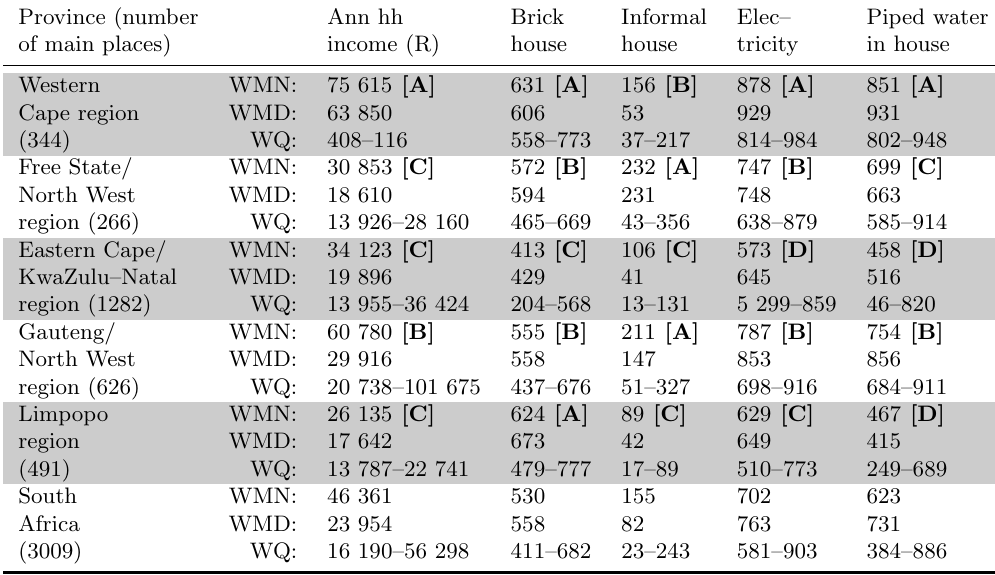
Comparing the five intramax regions with regards to household income, type of housing and services per 1 000 of households. [A] to [D]: different symbols indicate which means of these variables (comparing different regions in descending order from [A] to [D]) are significantly different, Bonferroni multiple comparison test, p < 0 . 05 . The following abbreviations are used: WMN for weighted mean per 1 000 households, WMD for weighted median per 1 000 households and WQ for weighted inter-quartile range per 1 000